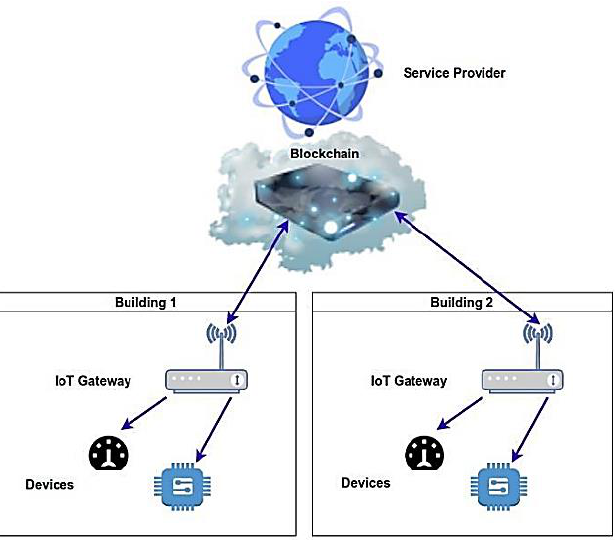
Figure 3. AMI-Blockchain Application Architecture.